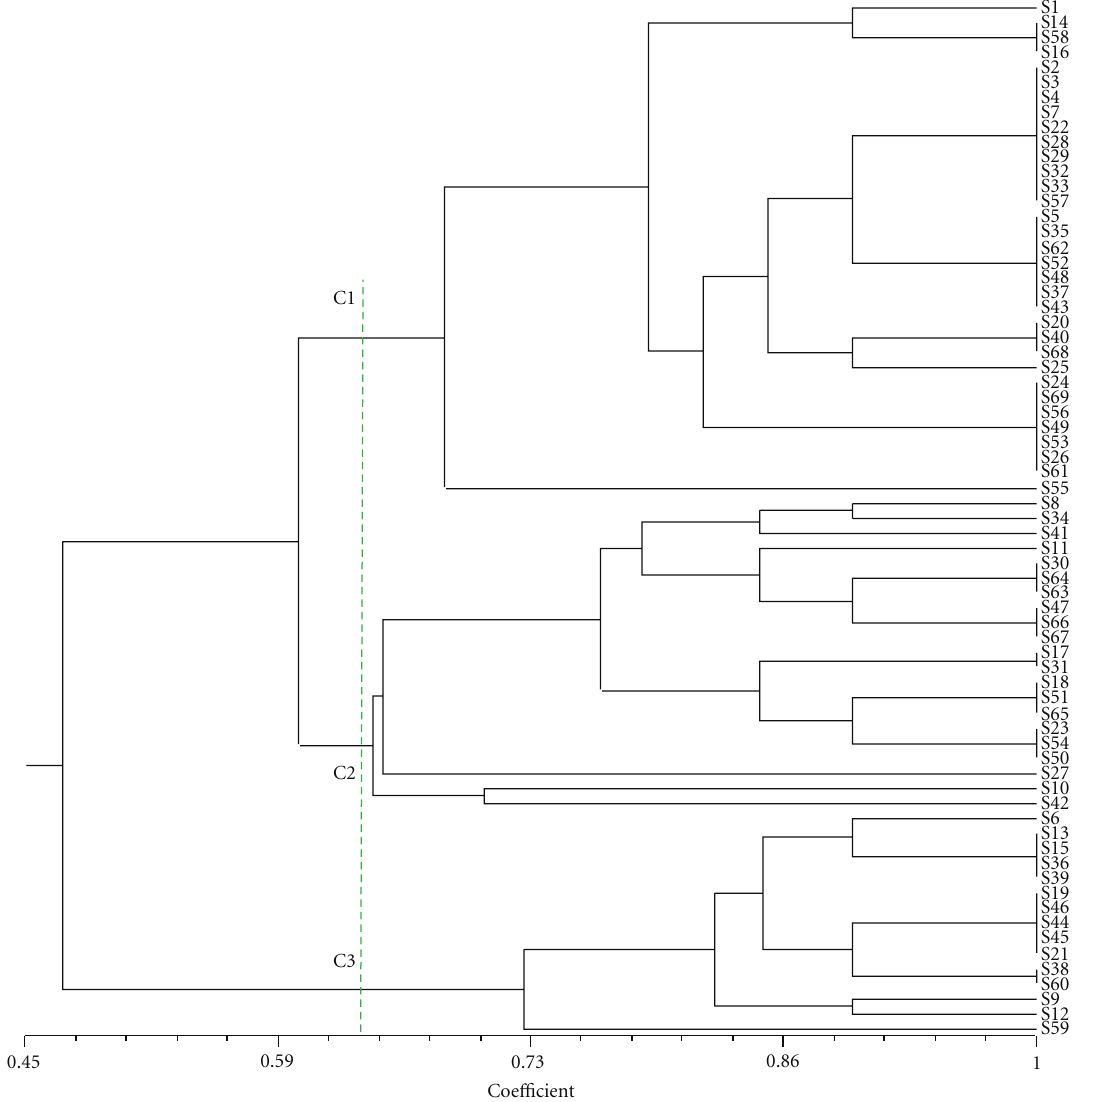
Figure 5: Dendrogram showing the classification of the species base on their habitat and their domestication